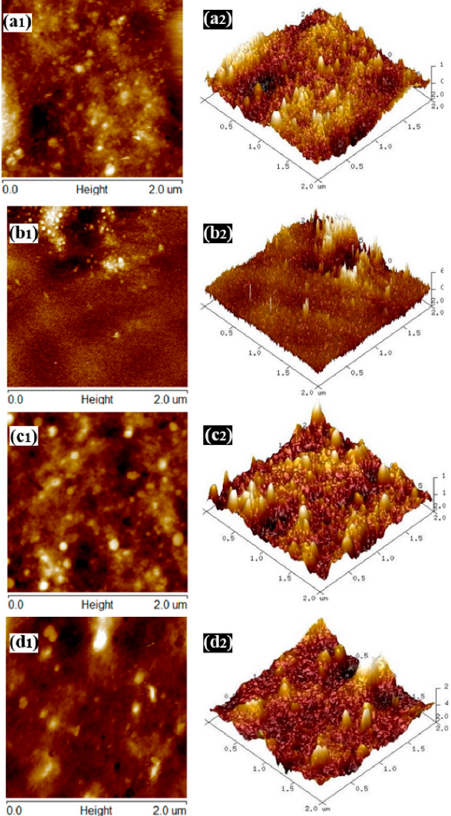
Figure 7. Atomic force microscopy (AFM) height images ( a1 – d1 ) and the 3D topography ( a2 – d2 ) of films a – d .